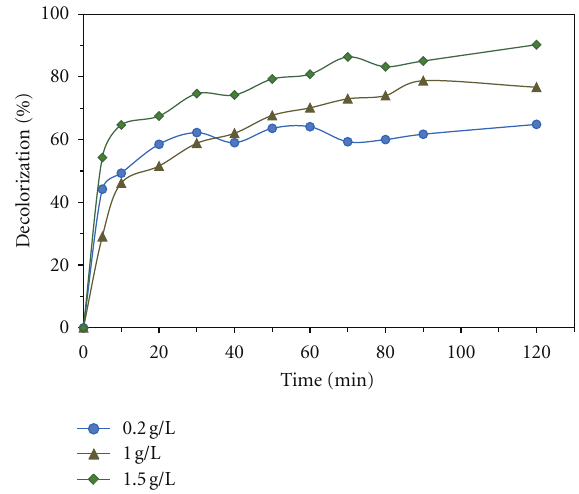
Figure 4: Decolorization percentage at various concentrations of glucose at [MG] 0 = 15 mg/L, [enzyme] 0 = 1000 U/L, [Fe 2+ ] 0 = 10 mM, and T = 30 ◦ C.